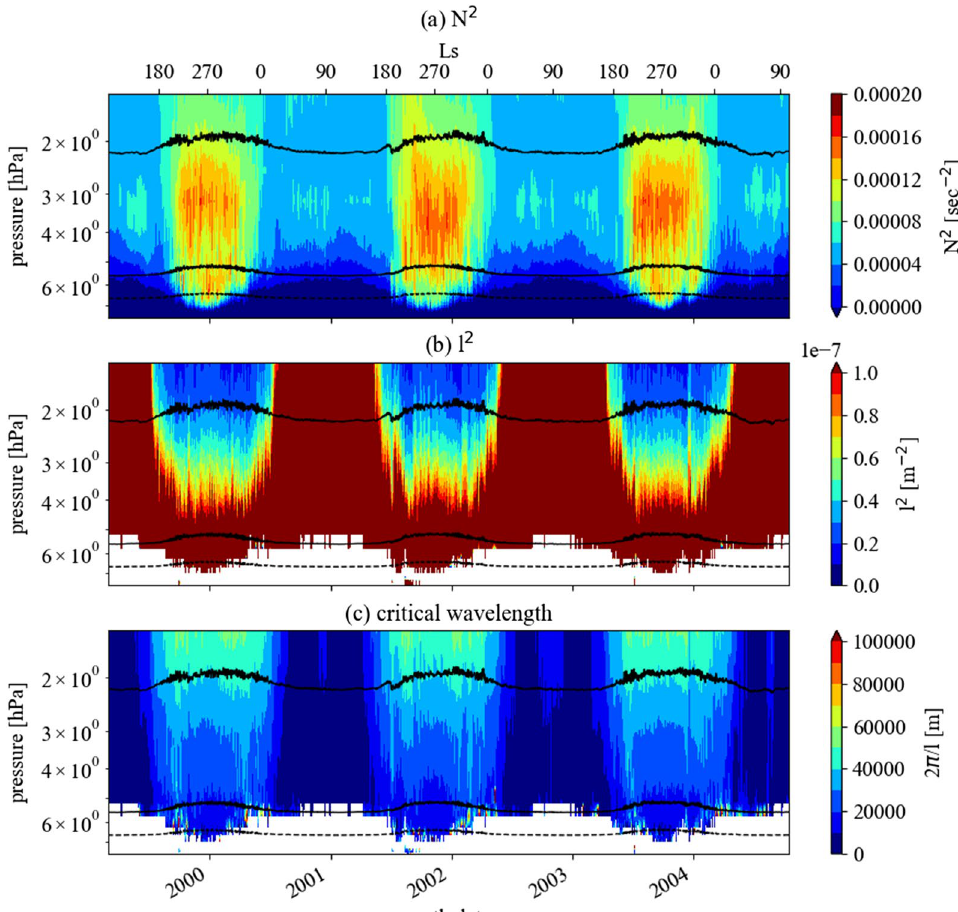
Fig. 5 The seasonal variations of the vertical profiles of the variables included in Eq. (2). a N 2 , b l 2 , and c 2 π/ l for 1400LT in the same region as Fig. 4 are displayed. The two solid and one dashed lines in each panel indicate the seasonal variations in geopotential height of 10 km, 0 km, and -2 km, respectively. The white areas in Panels b and c show the absolutely unstable layer near the